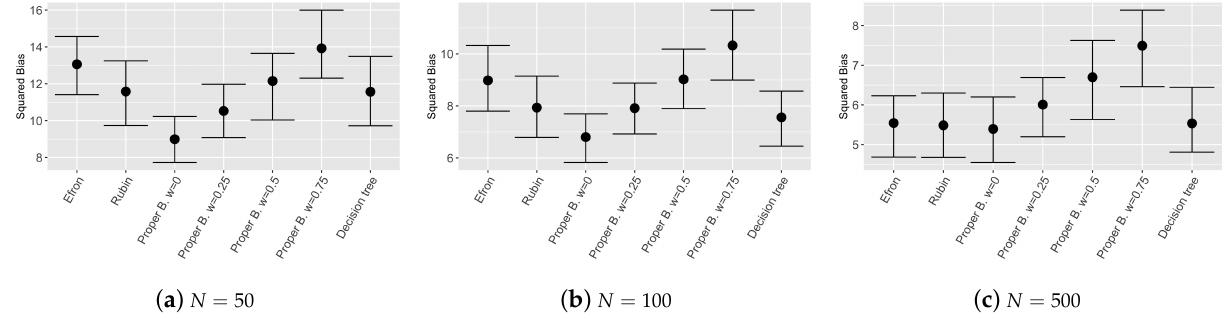
Figure 4. Nonparametric confidence intervals for the squared bias on the validation set varying N , number of observations in the training